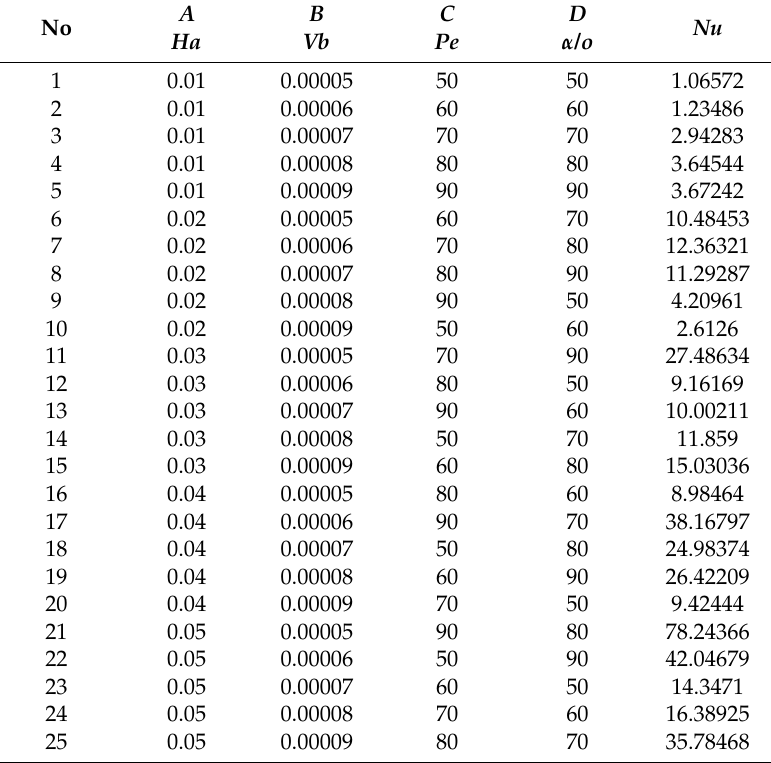
Table 2. Orthogonal design table and results for the four factors with five